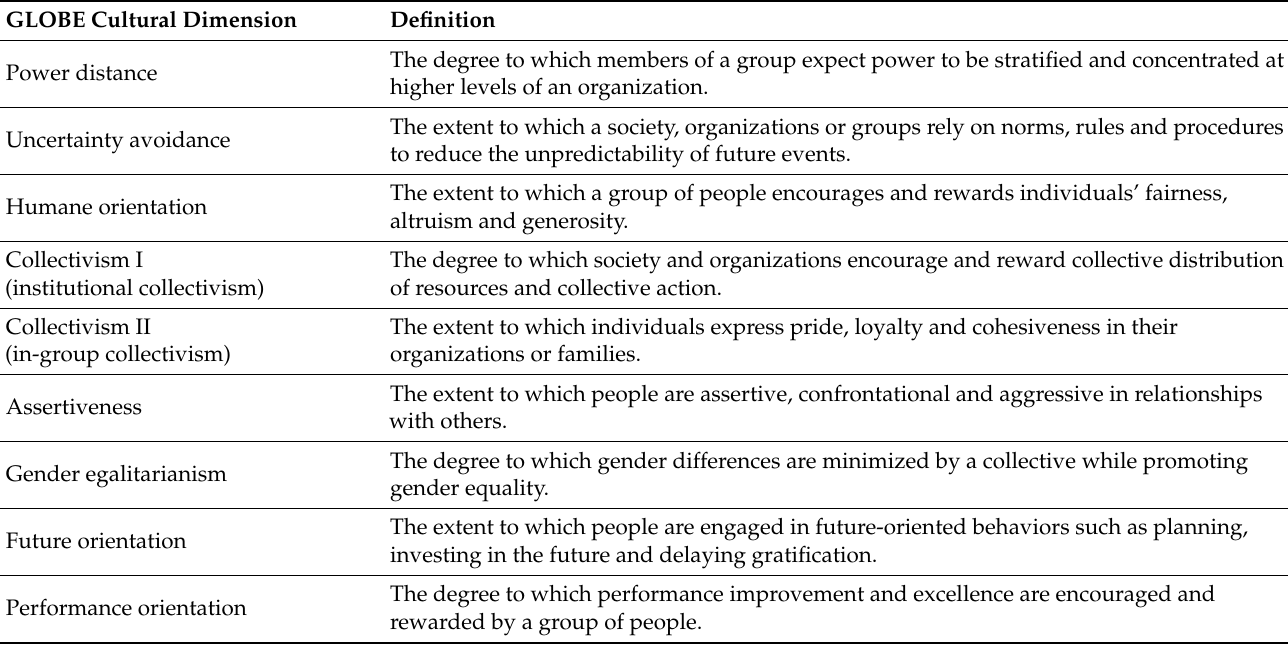
Table 2. Global Leadership and Organizational Behavior Effectiveness (GLOBE) cultural dimensions (House et al. 2004). GLOBE Cultural